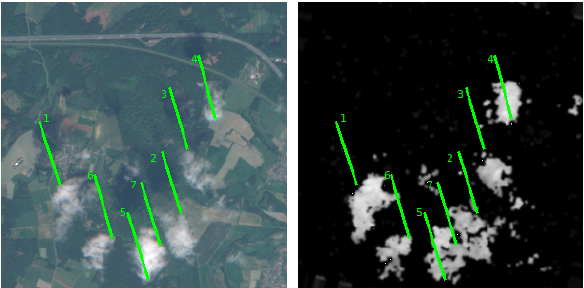
Figure 18. Left: Ortho image Fch, right: cloud heights above ground Fch (black: 0 m, white: 2048 m), green lines: manually measured cloud/shadow borders